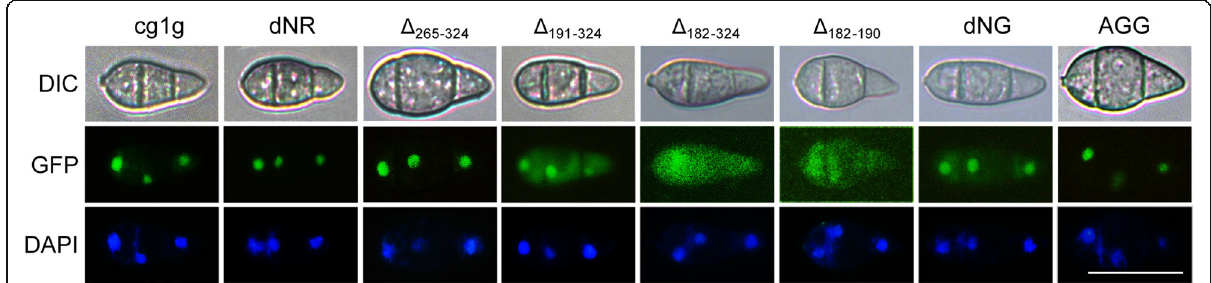
Fig. 8 The sequence between the 1st and 2nd RGG is essential to nuclear localization of MoGrp1. Subcellular localization of the C-terminal GFP tagged MoGrp1 (cg1g) construct and its mutated alleles dNR (MoGrp1 Δ 1 – 173 ), Δ 265 – 324 (MoGrp1 Δ 265 – 324 ), Δ 191 – 324 (MoGrp1 Δ 191 – 324 ), Δ 182 – 324 (MoGrp1 Δ 182 – 324